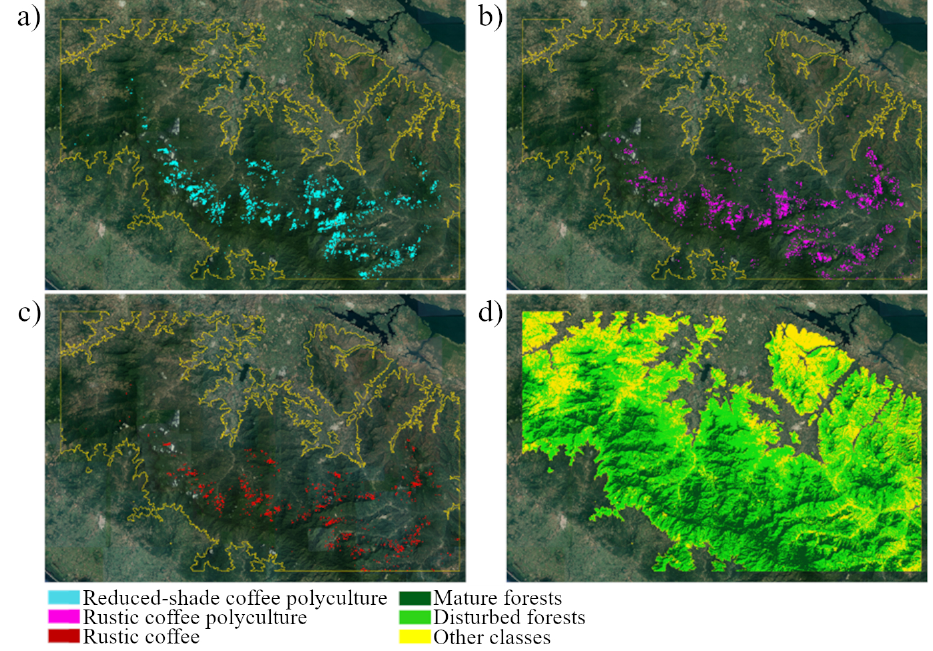
Figure 5. Individual maps for ( a ) reduced-shade coffee polyculture, ( b ) rustic coffee polyculture, ( c ) rustic coffee, and ( d ) mature forest, disturbed forest and other